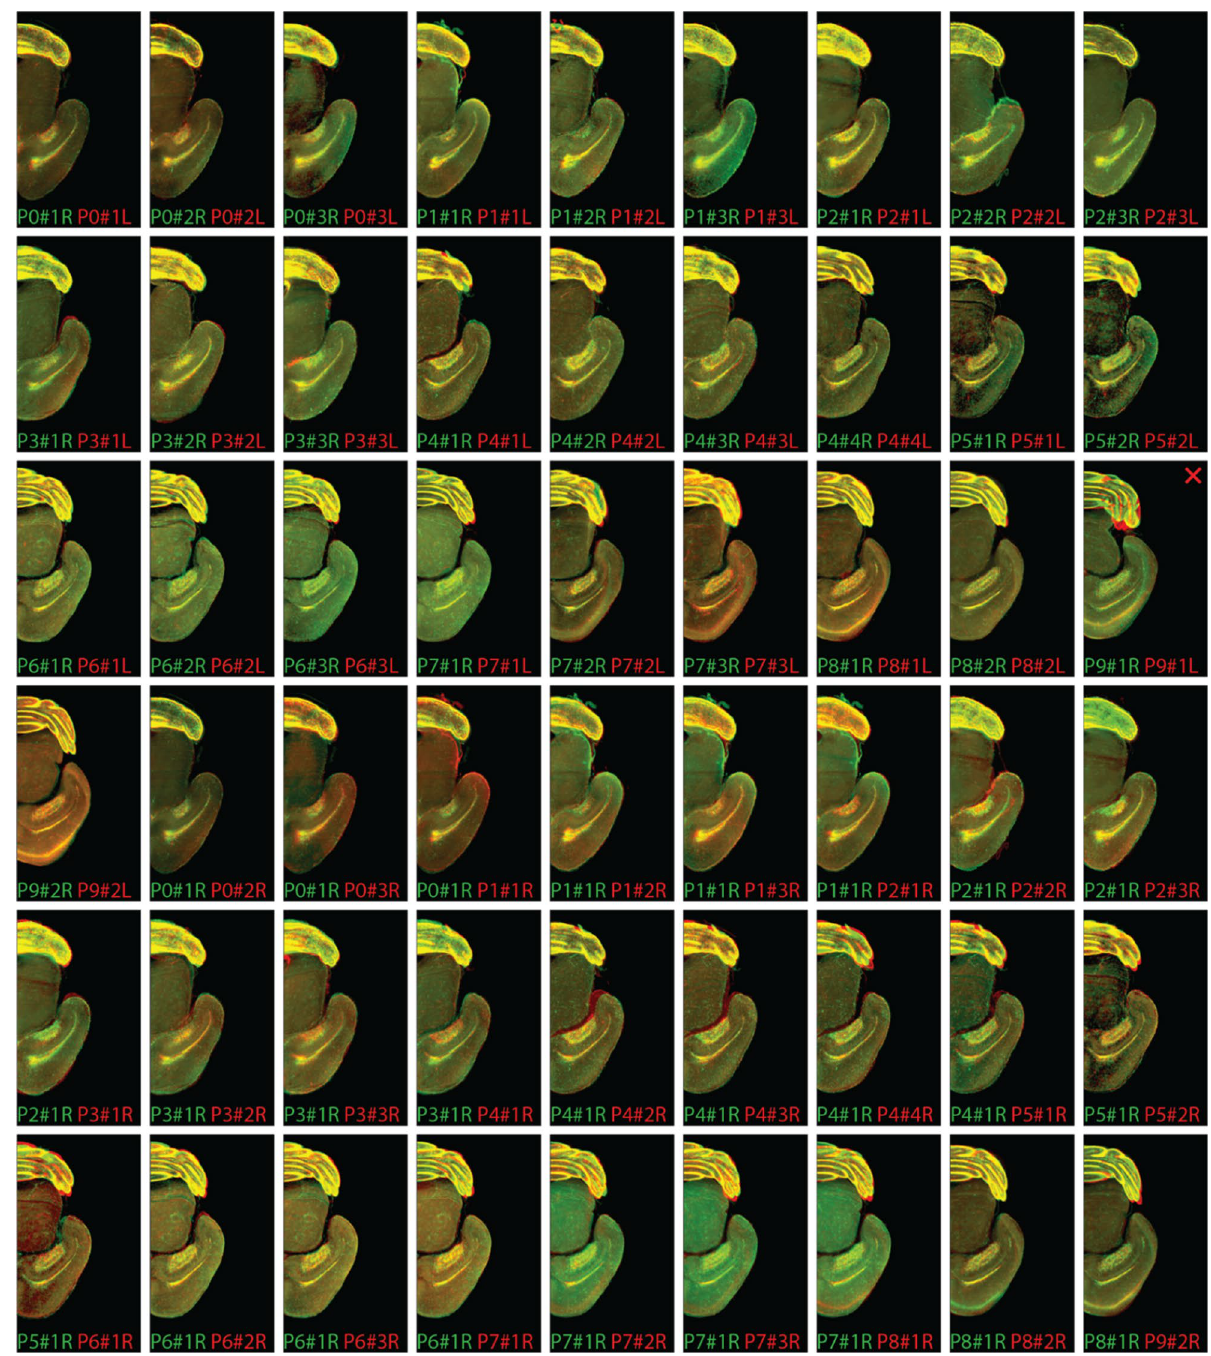
Figure 4. Registration was successful for 53 of 54 pairs of hemispheres from 28 whole-mount samples of developing brains in the testing set. Top three rows and the first image in the fourth row: 28 pairs of left/right hemispheres from the same brains aligned to each other (27 successful). Bottom three rows, beginning from the second image: 26 pairs of pre-registered hemispheres from 27 different brains (the 28th brain with misaligned left/right hemispheres was not used here). For each aligned pair, we show a representative 2D optical section to illustrate the match of individual brain regions and highlight the potential differences. The 1 unsuccessfully registered pair of hemispheres is marked with the “X” sign (see